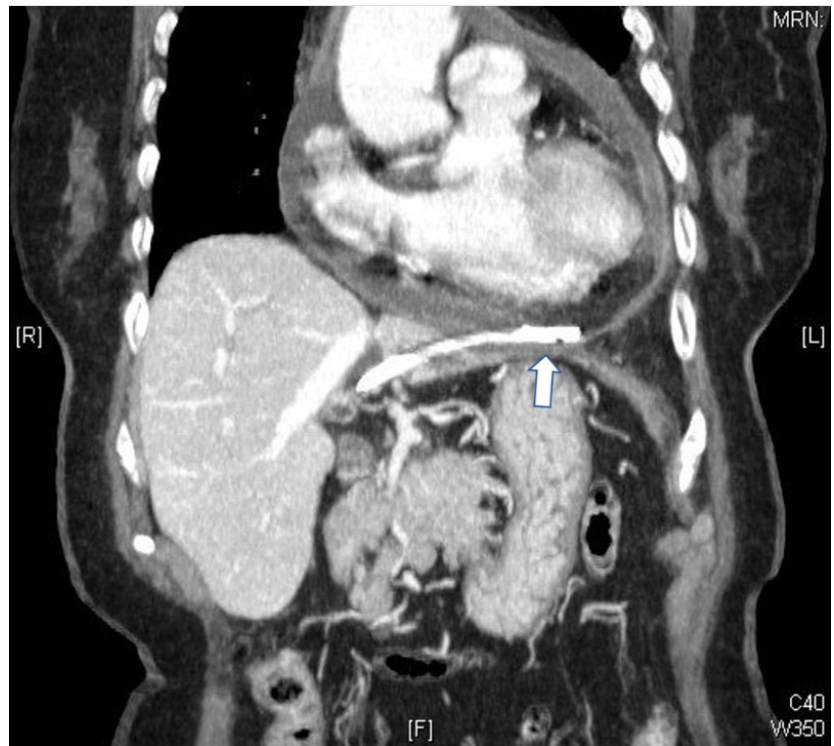
Figure 2. Migrated stent after penetration of the pericardium. One tip of the migrated stent was in the duodenum and the other tip penetrated into the pericardium through the lateral segment of left liver.